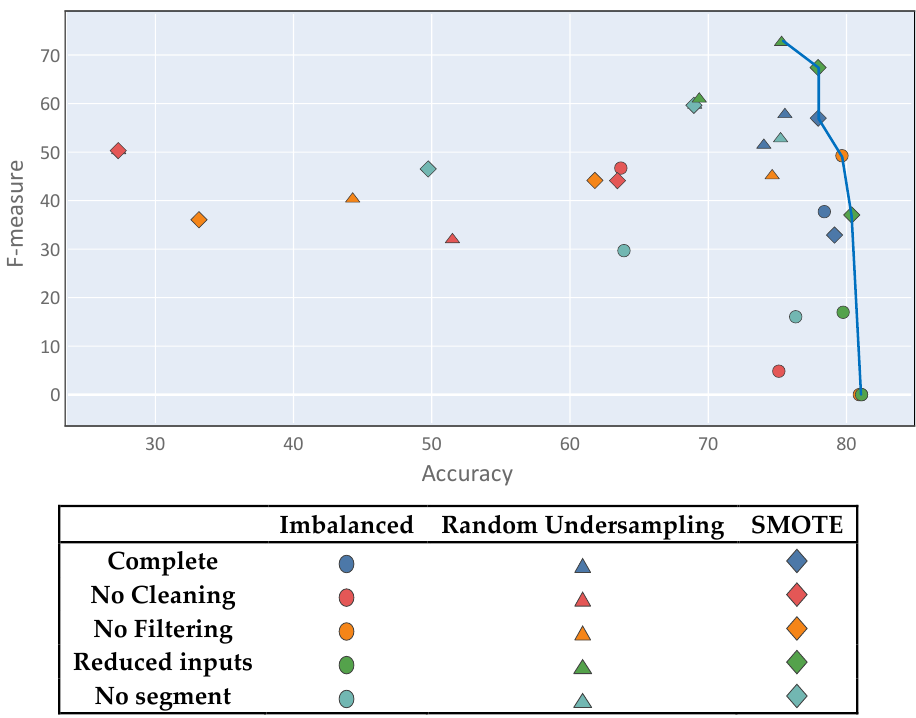
Figure 16. Multi-objective problem Pareto front.